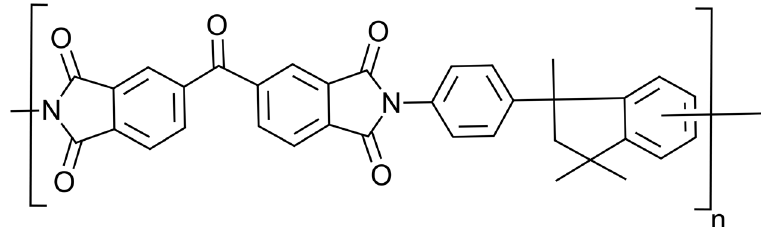
Figure 8. Structure of